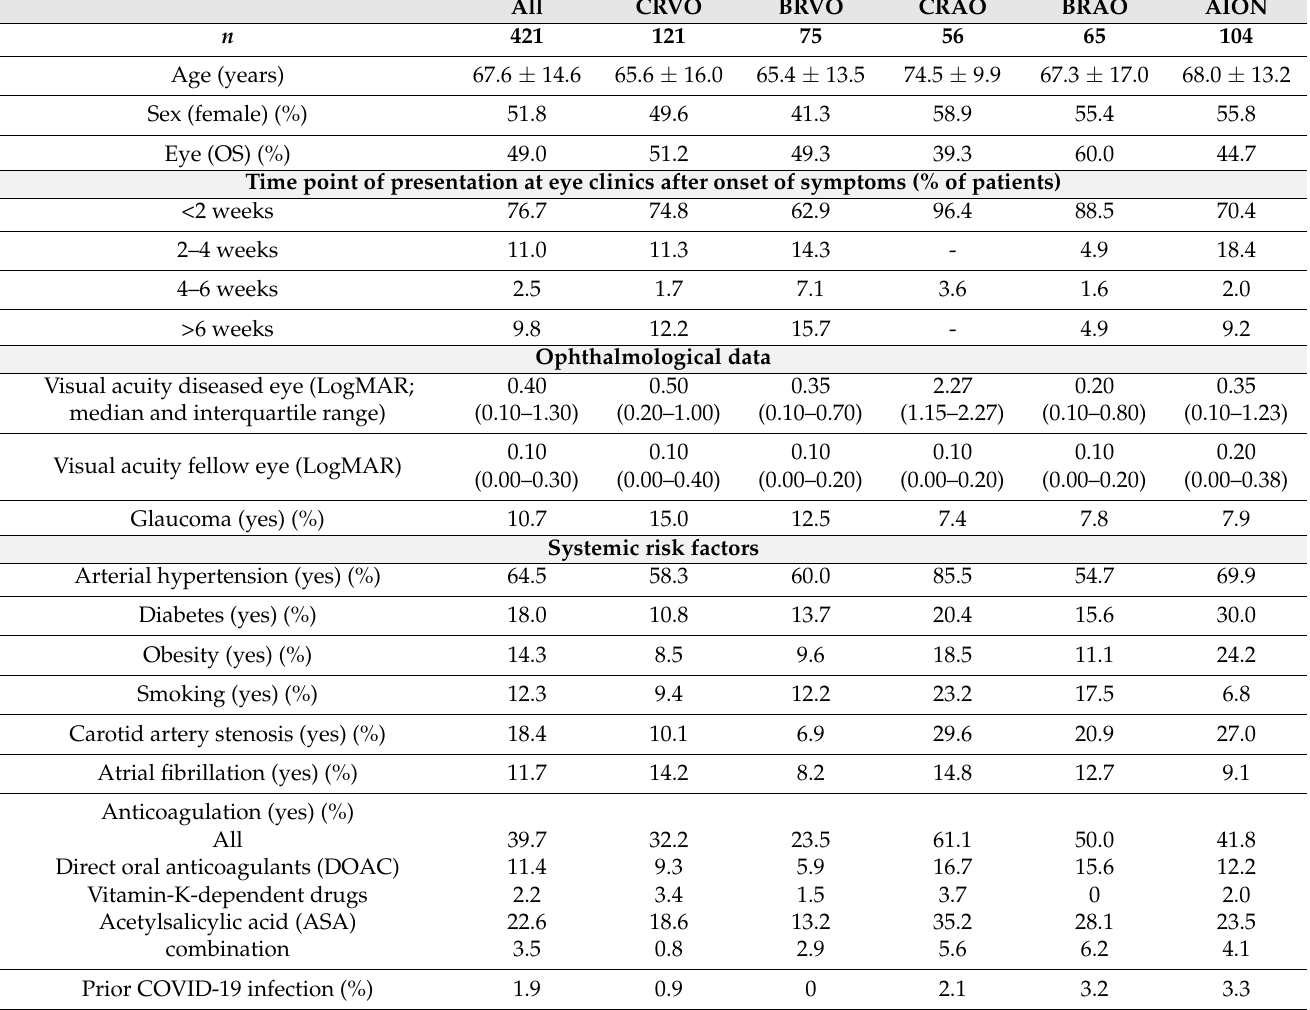
Table 1. Characteristics of the study participants with RVOD.